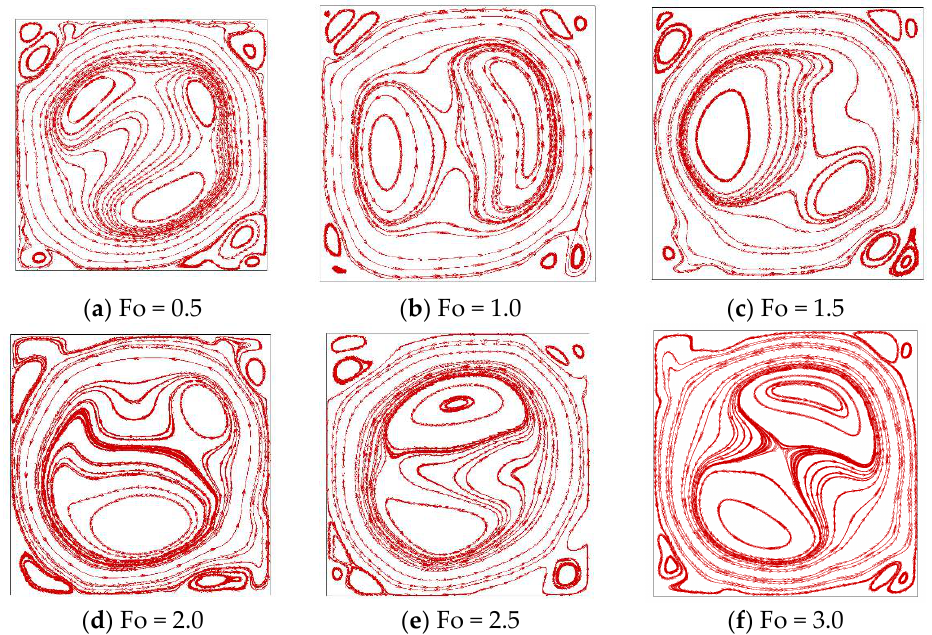
Figure A1. Streamlines at different times ( a – f ) for natural convection in a side-heated square cavity. Pr = 0.01. The solution is oscillatory and never reaches the steady-state.